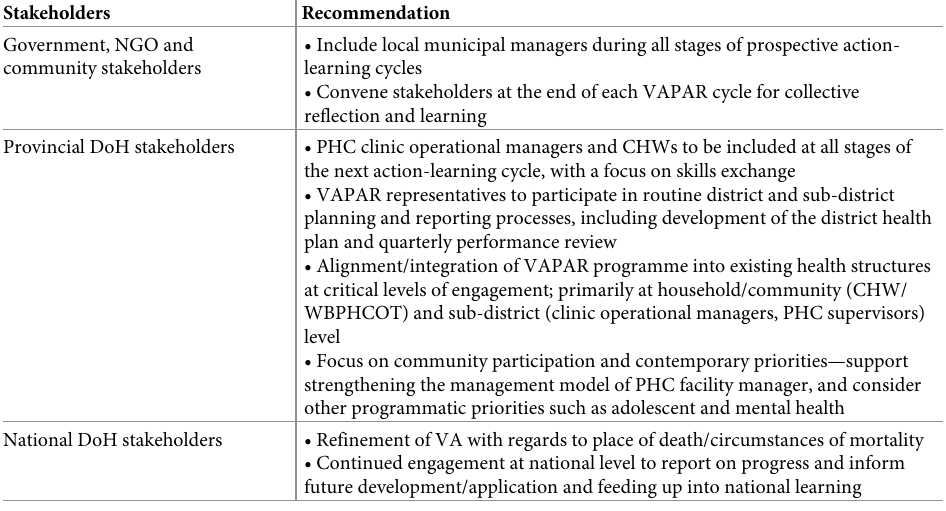
Table 2. Collective recommendations on integration into routine health systems